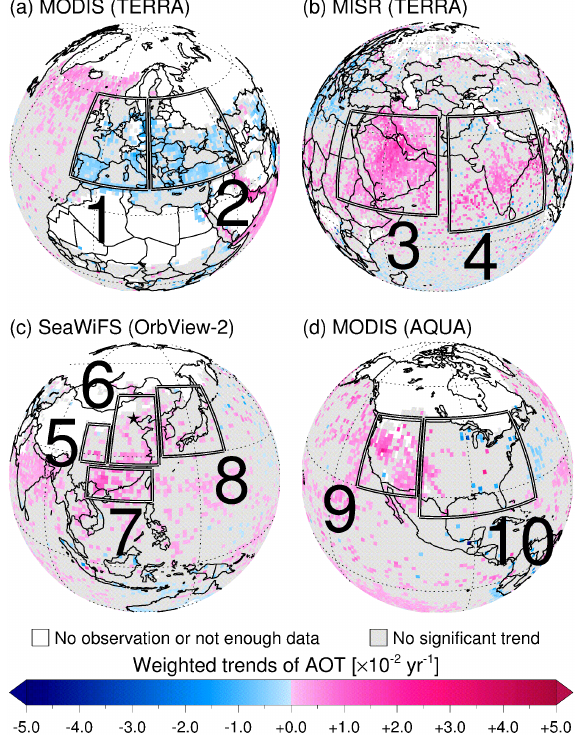
Figure 10. Weighted trends derived from satellite-retrieved AOTs for the selected regions. Each spaceborne instrument has a different local sampling time; the equatorial crossing times for the satellites are 10:30 for Terra (descending node), 12:20 for OrbView-2 (de- scending node), and 13:30 for Aqua (ascending node). Weighted trends ( B g ) for each grid with significance 2 are shown in grey, representing nonsignificant